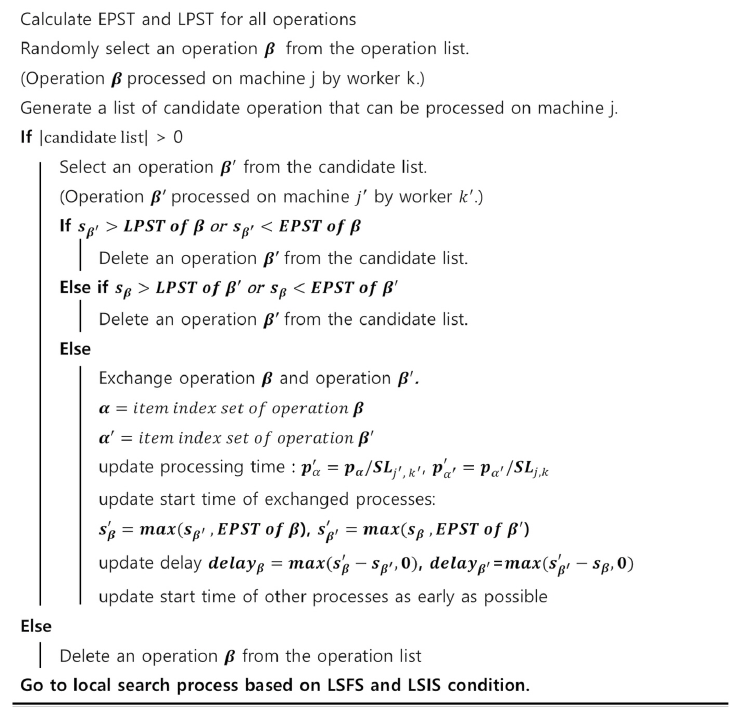
Figure 5. Pseudocode for candidate solution